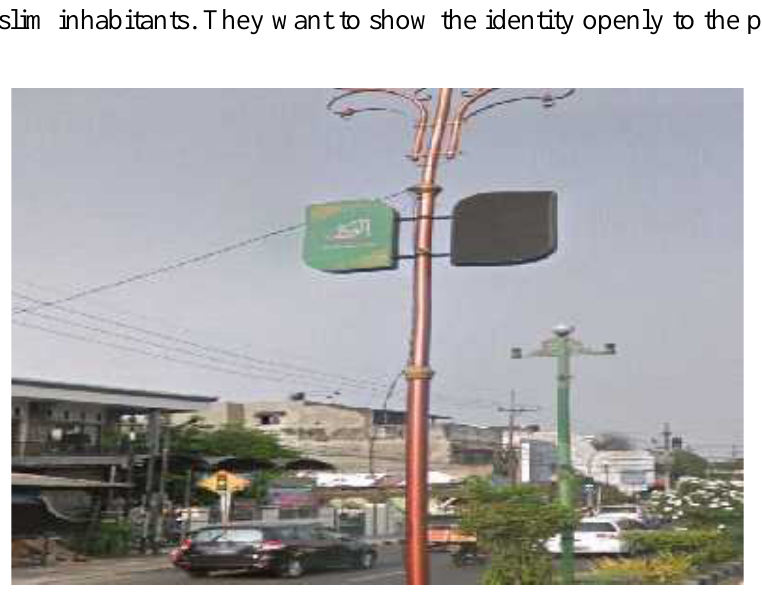
Figure 8. Asmaul Husna